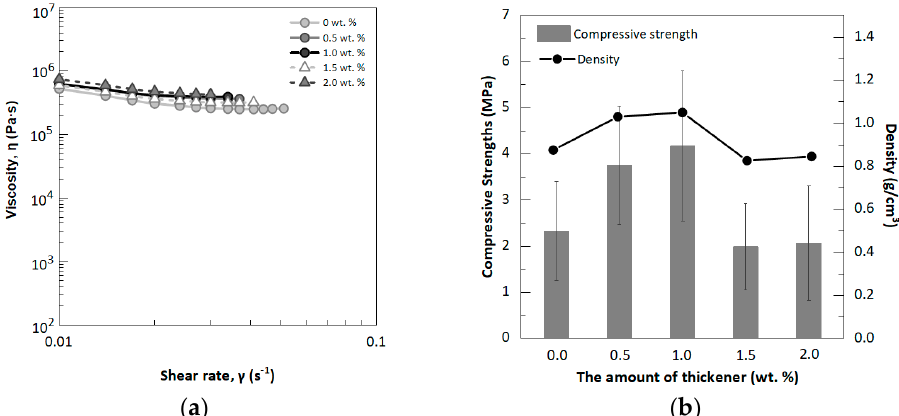
Figure 10. (a) Viscosities of the ZTA slurries with different amounts of thickener, and (b) compres- Figure 10. ( a ) Viscosities of the ZTA slurries with different amounts of thickener, and ( b ) compressive strengths and density sive strengths and density levels of the ZTA slurries depending on the amount of thickener used . levels of the ZTA slurries depending on the amount of thickener